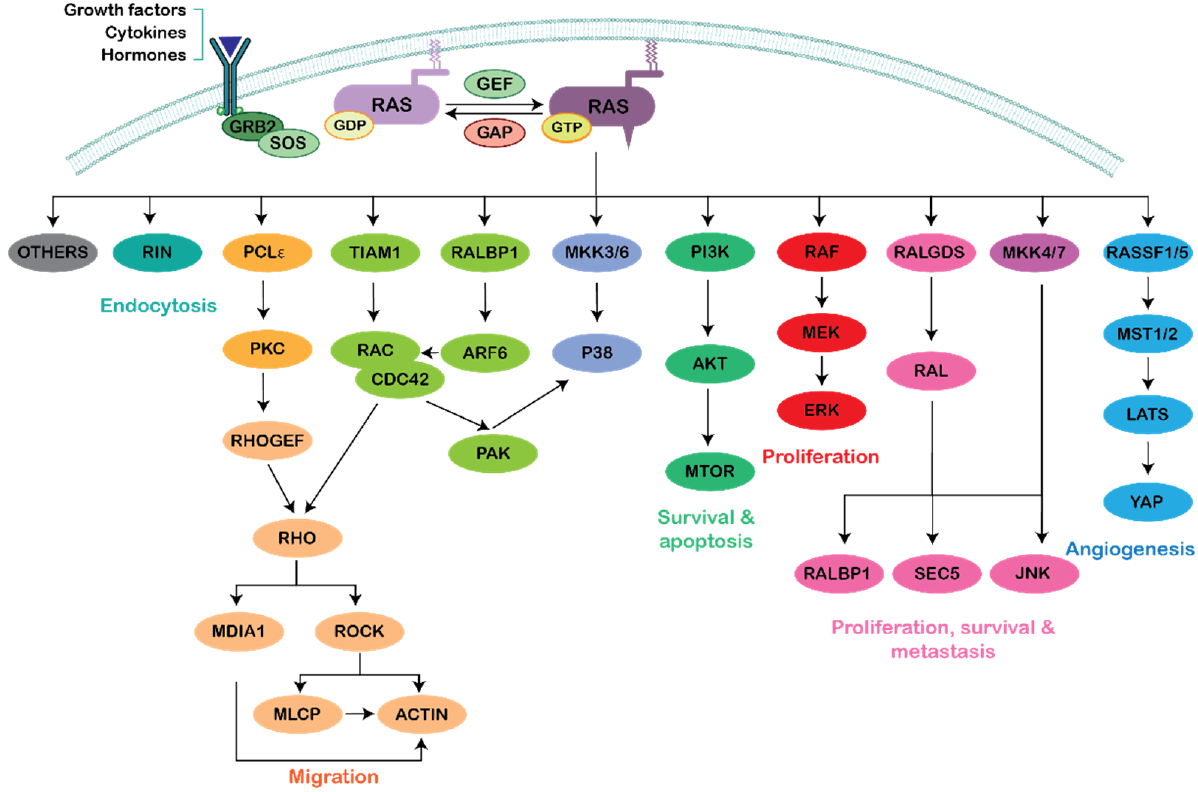
Figure 1. RAS effector pathways. Plasma membrane-associated Ras-GTP can directly interact with multiple, different effectors to activate various signaling cascades, regulating different cellular functions such as cell proliferation, migration, survival/death, differentiation, endocytosis migration and adhesion.